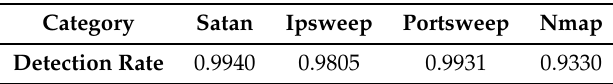
Table 3. The detection rates of the